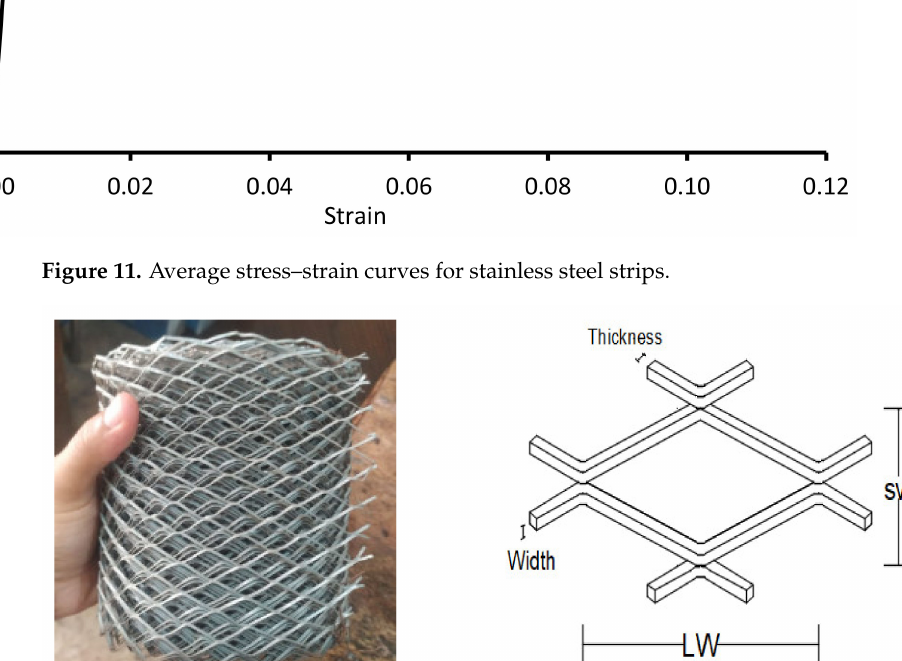
Figure 12. Steel wire